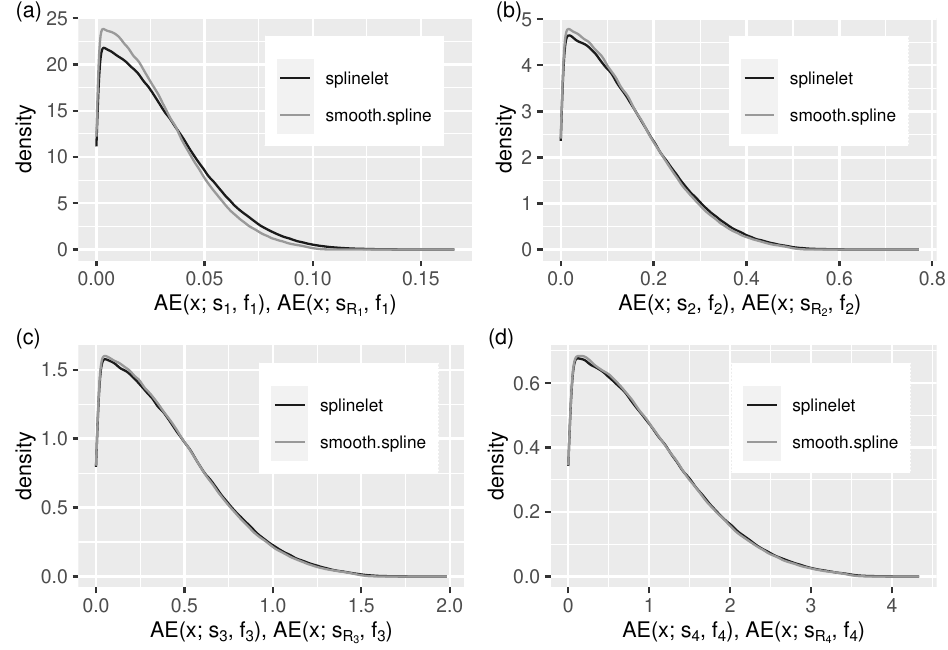
Figure 6. Cubic splinelet generated spline vs. smoothing spline: distribution of absolute approxima- tion errors (in the form of a density function) for all test streams, ( a – d ) f 1 – f 4